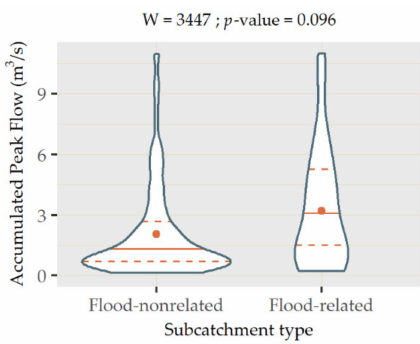
Figure 7. Violin plot of the values of accumulated peak flow in flood-related and flood-nonrelated